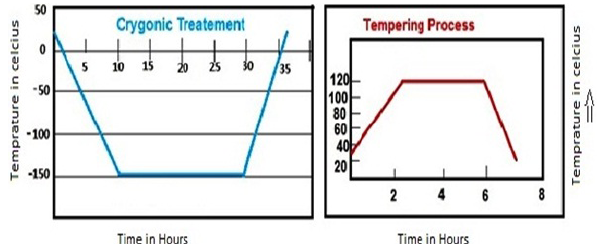
Figure 1. Cryogenic treatment and tempering (CTT; Singh and Singh, 2011).